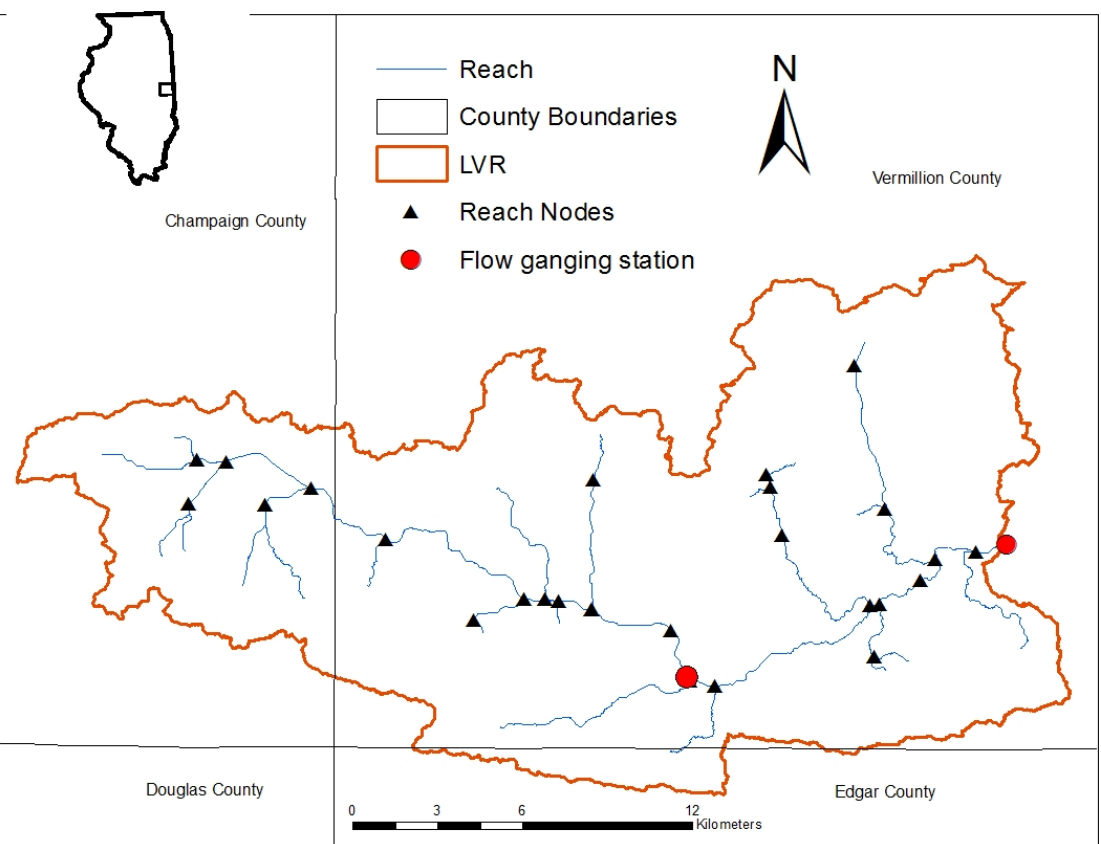
Figure 1. Map and Stations Location of study watershed.